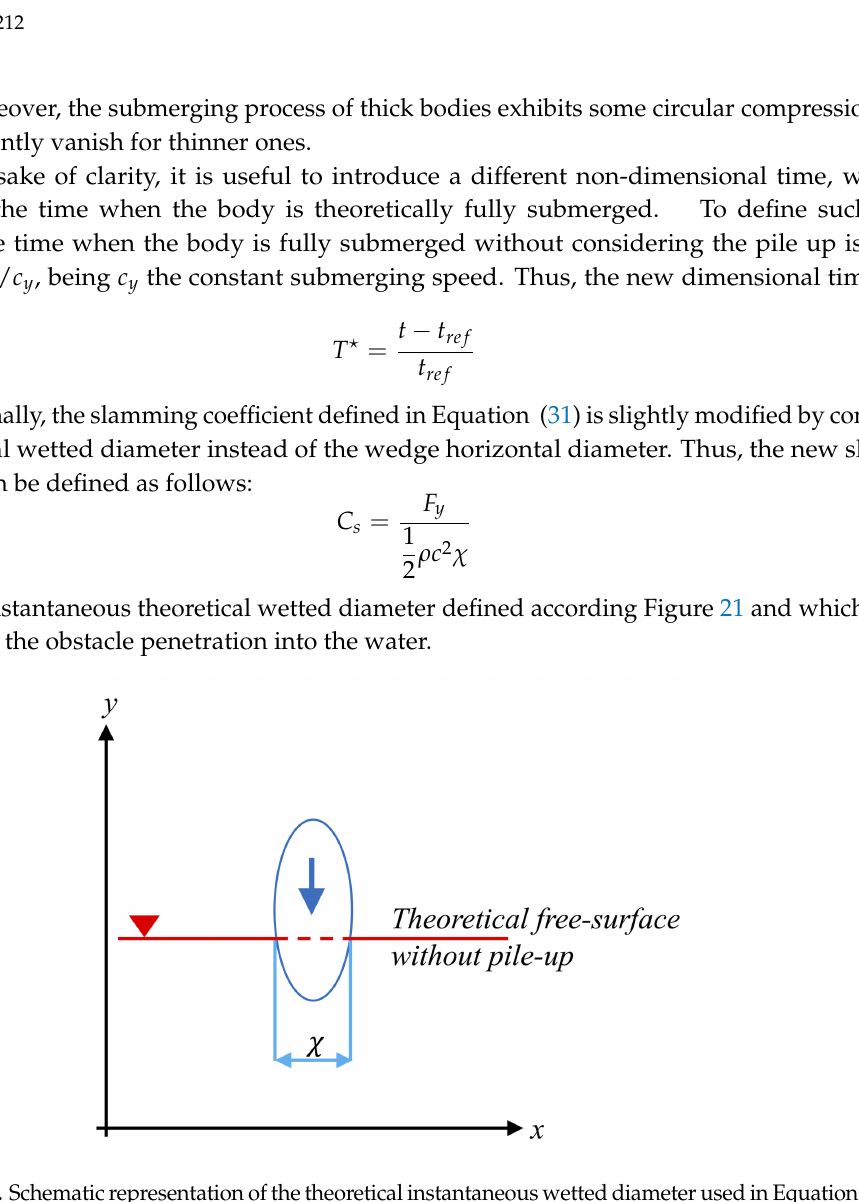
Figure 21. Schematic representation of the theoretical instantaneous wetted diameter used in Equation